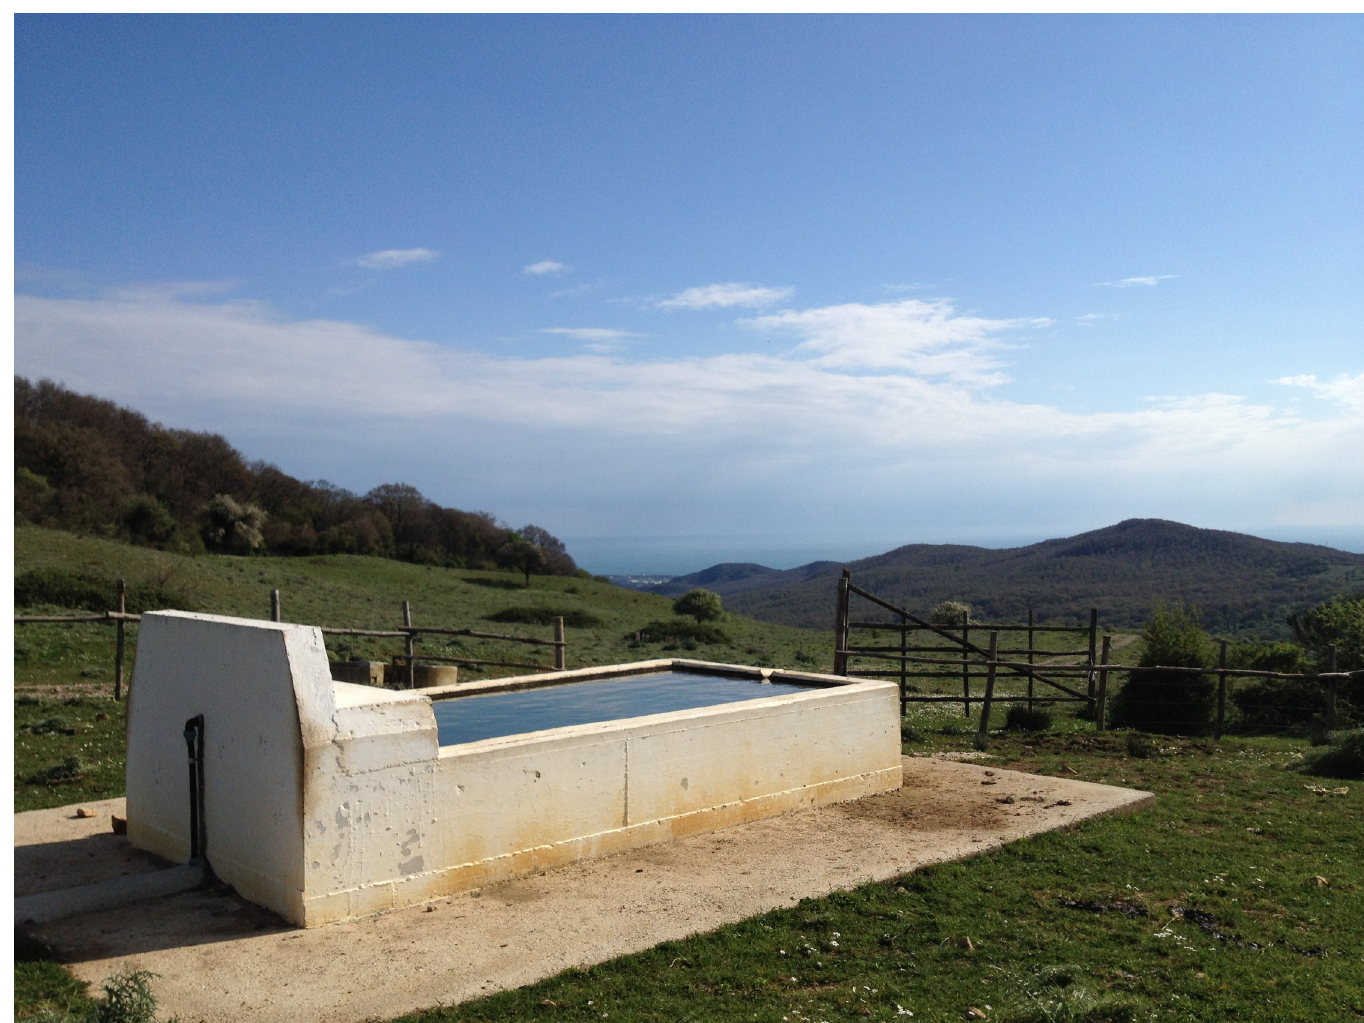
Fig 2. Drinking trough. Example of a trough in the study